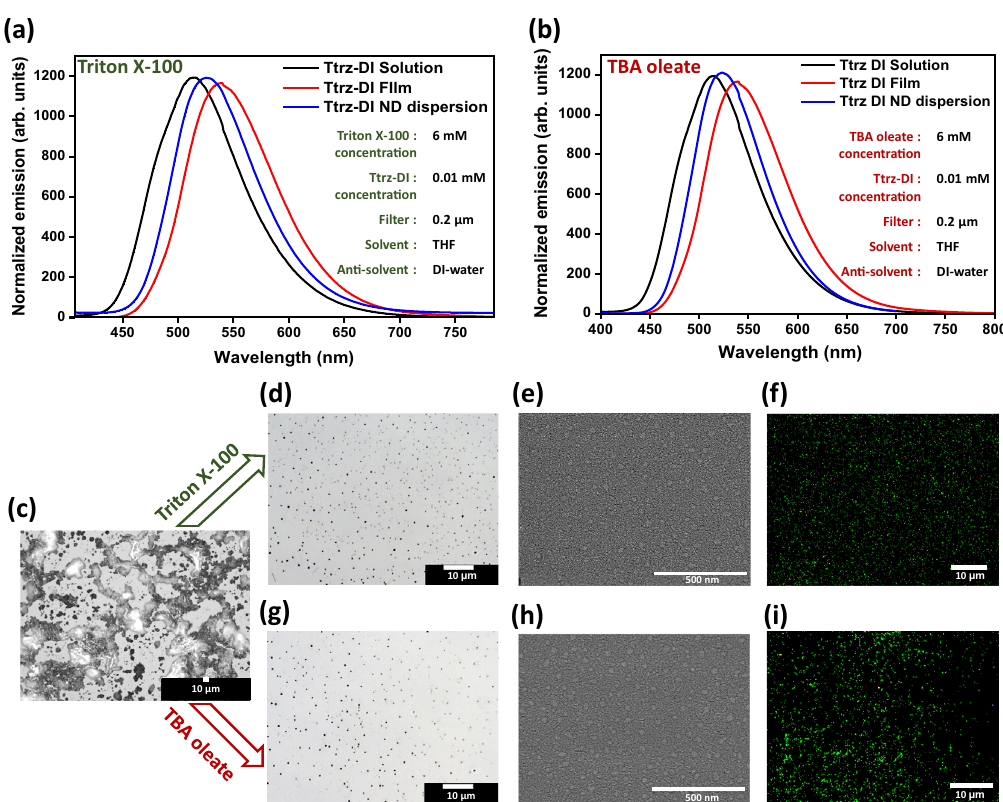
Fig. 2 PL spectra of solution, fi lm, and nano-dot dispersions of Ttrz-DI. Prepared using a Triton X-100 and b TBA oleate. Optical microscope (OM) images of a Ttrz-DI dispersion deposited on a glass substrate synthesized c without surfactant and d with 6 mM Triton X-100 surfactant. e SEM image of a Ttrz-DI ND/Triton X-100 dispersion deposited on a glass substrate. f Fluorescence microscope (FM) image of a Ttrz-DI ND/Triton X-100 dispersion deposited on a glass substrate. Optical microscope images of a Ttrz-DI dispersion deposited on glass a substrate synthesized g with 6 mM TBA oleate surfactant. h SEM image of a Ttrz-DI ND/TBA dispersion deposited on a glass substrate. i Fluorescence microscope image of a Ttrz-DI ND/TBA oleate dispersion deposited on a glass